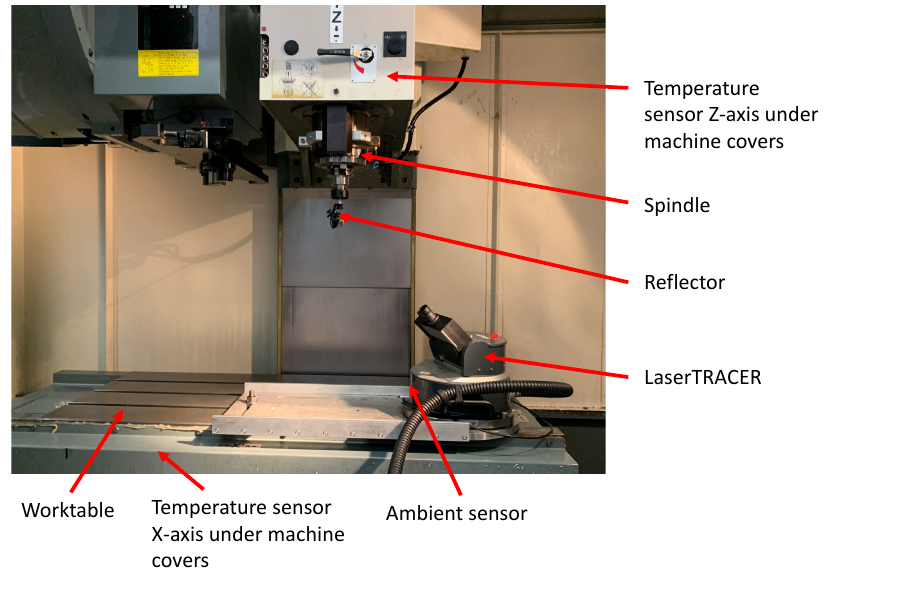
Figure 3. Configurations of tracking the laser